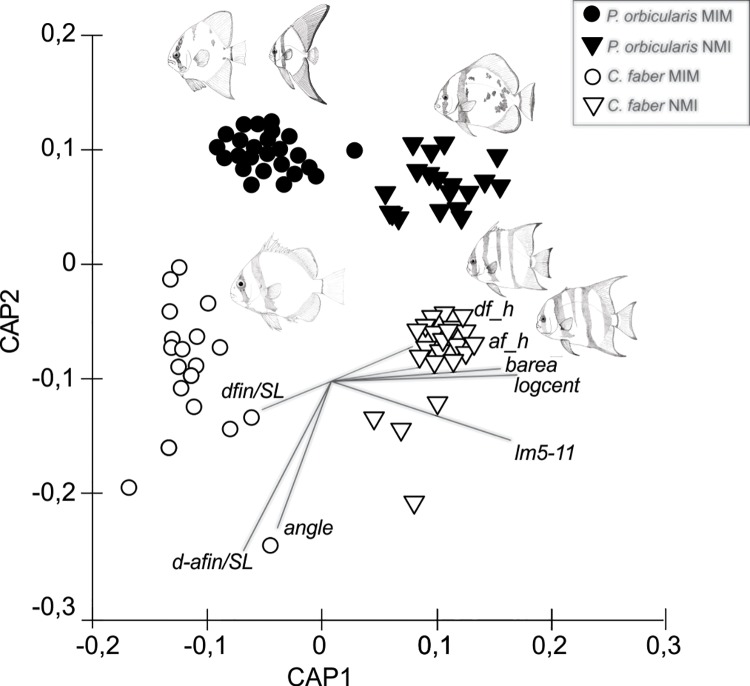
CAP analysis.Constrained canonical analysis of principal coordinates (CAP) ordination plot (Euclidean distance) of mimetic (MIM) and non-mimetic (NMI) individuals of two ephippid fish (C. faber and P. orbicularis) based on morphometric measurements data, showing the levels of similarity among groups of mimetic individuals (MIM, circles) and non-mimetic individuals (NMI, triangles), C. faber (white symbols) and P. orbicularis (black symbols).